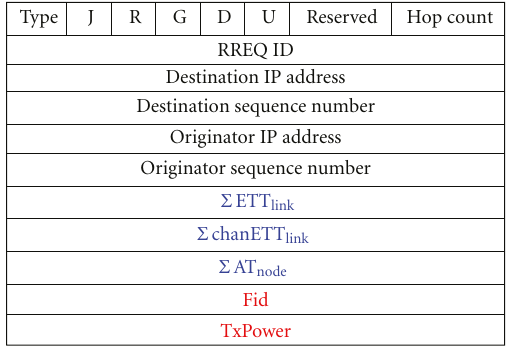
Table 1: Delay-Throughput with di ff erent power levels.